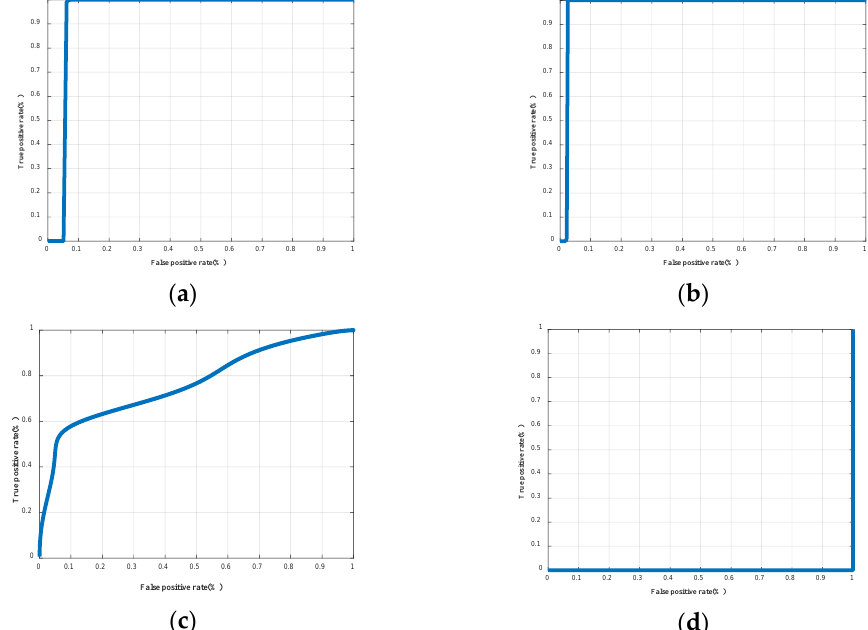
Figure 11. Receiver operating characteristic (ROC) curves for cancellable face recognition frameworks (for ORL dataset) for ( a ) CFR1, ( b ) CFR2, ( c ) homomorphic transform followed by salting and ( d ) homomorphic transform followed by random kernel convolution.